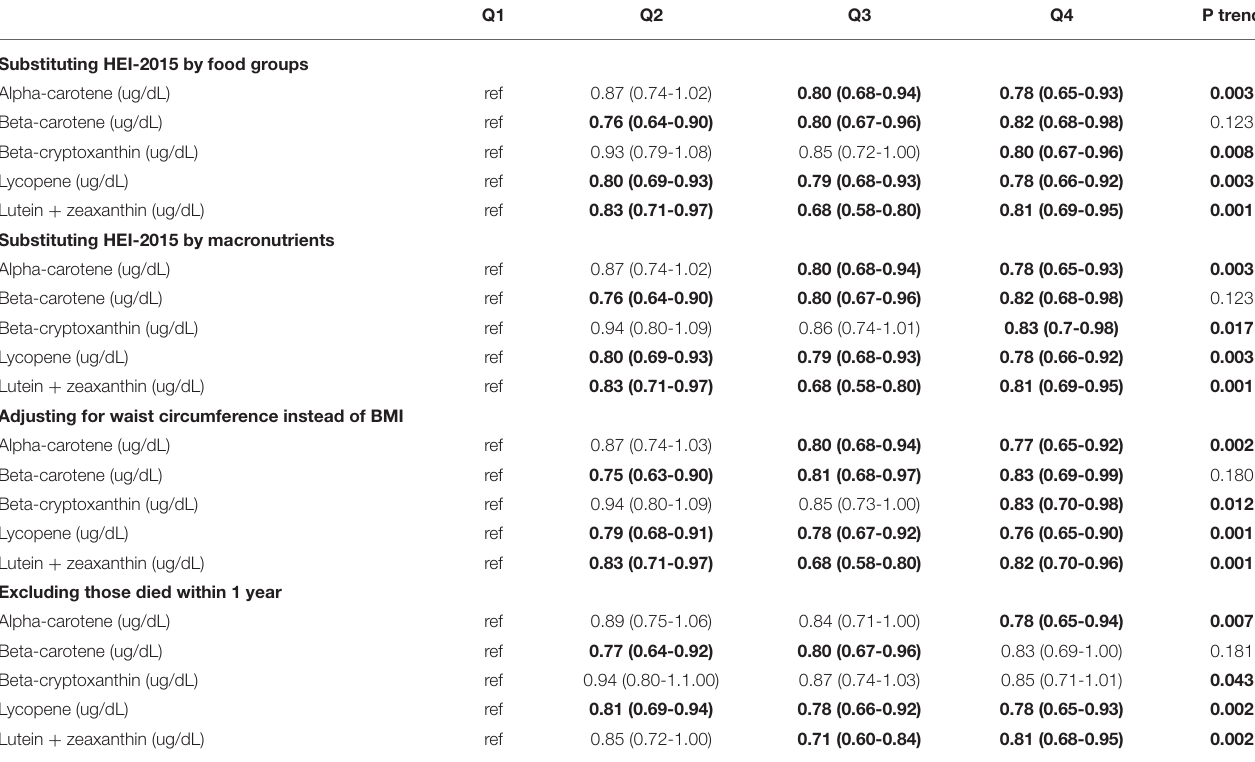
Allanalysesadjustedforage,sex,familyincome-povertyratiolevel,race,educationlevel,maritalstatus,alcoholconsumption,smoking,andleisure-timephysicalactivity,log-transformed total energy intake, HEI-2015 (if not specified), baseline eGFR, log-transformed urinary ACR, body mass index, total-to-HDL cholesterol ratio, serum phosphorus, hemoglobin, hypertension, and diabetes, and history of cardiovascular disease and